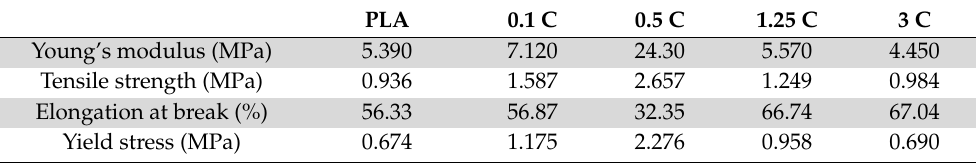
Table 1. Mechanical performances of MWCNT-containing nanofibers.